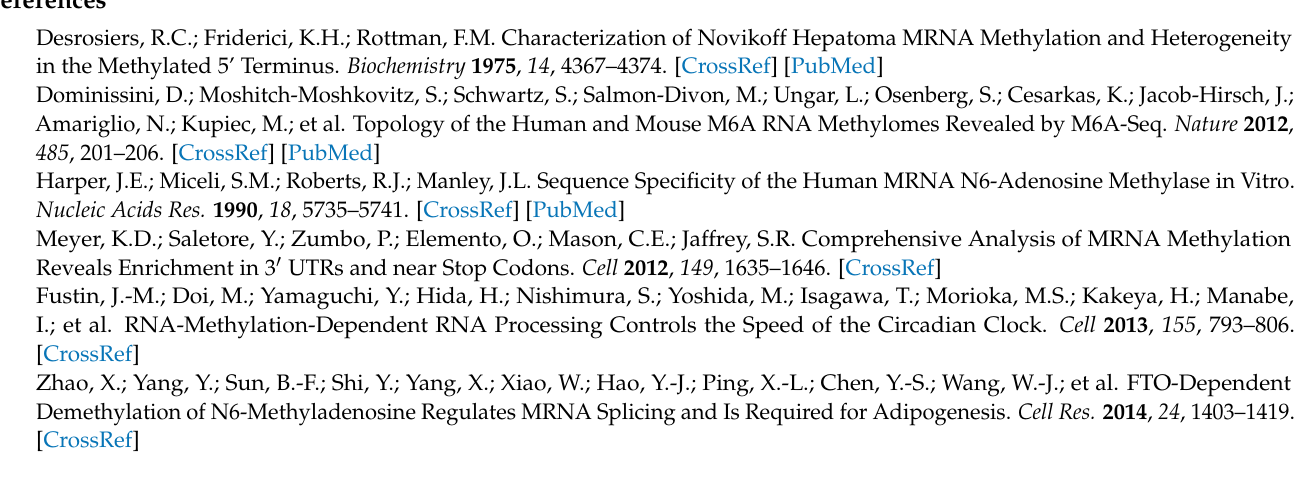
18 h; Figure S1: Kinetic parameter determination of the METTL3-14 complex by using screening assay system, Figure S2: Confirmation of false-positive potential, Figure S3: The anti-proliferative activity of gilteritinib as positive control was confirmed a GI 50 value of 16.6 nM in MOLM-13. Figure S4: m 6 A levels on poly-A+-enriched mRNA after 24 h of eltrombopag treatment (40 µ M) or 4 days after post- transduction of siRNA in MOLM-13, Figure S5: Analysis of combination treatment of AML drugs, gilteritinib and sorafenib, with eltrombopag in MOLM-13, Figure S6: Distribution of significantly differential m 6 A methylated peaks detected in shMETTL3-treated Molm-13 cells, Figure S7: NMR spectrum of compound 14a , Figure S8: NMR spectrum of compound 14b , Figure S9: NMR spectrum of compound 14d , Table S1: Differential m 6 A methylation sites and peak annotation in Eltrombopag- treated Molm-13 cells, Table S2: Differential m 6 A methylation sites in shMETTL3-treated Molm-13 cells, Table S3: GO enrichment analysis of differentially m 6 A methylated